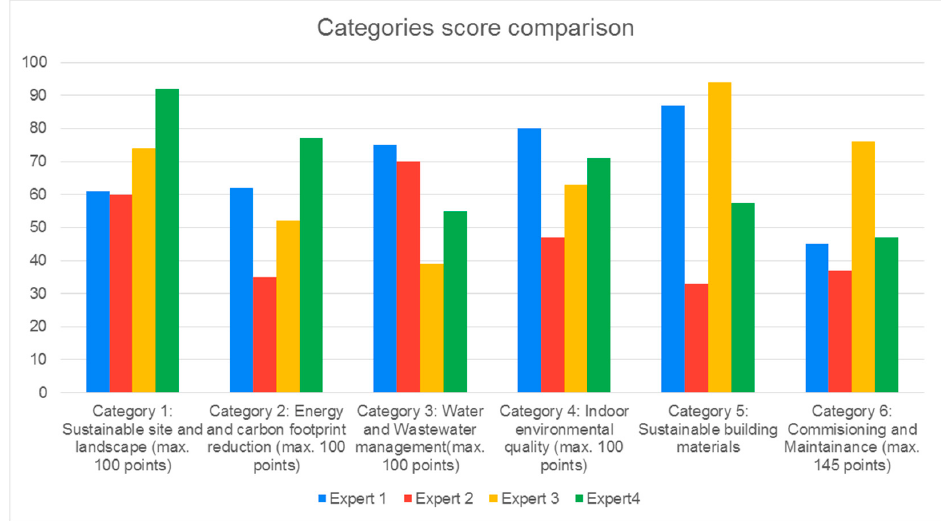
Figure 6. The “Green block” residential complex categories